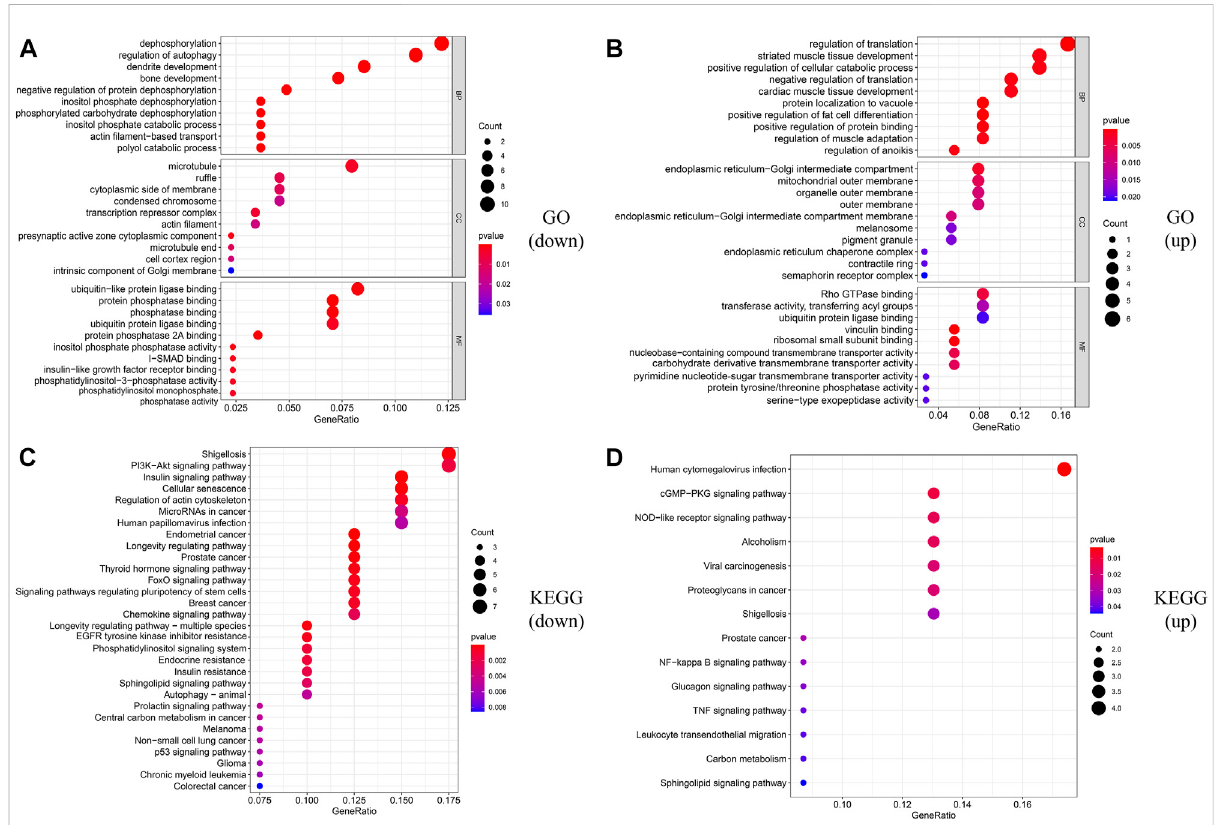
FIGURE 4 Functional enrichment analysis of lncRNA-related DE_mRNAs. (A , B) GO enrichment analysis of downregulated and upregulated lncRNA- related DE-mRNAs. (C , D) KEGG enrichment analysis of downregulated and upregulated lncRNA-related